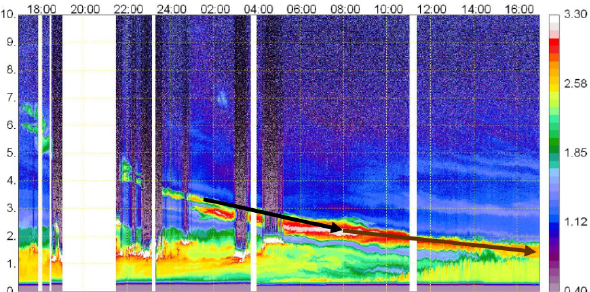
Figure 2. Logarithm of range-corrected signal of MULIS (multi- wavelength lidar system) at = 1064nm at Maisach from 16 April 2010, 17:00UTC to 17 April 2010, 17:00UTC and from 0 to 10km above ground; white areas denote periods without measurements (taken from Gasteiger et al., 2011). The two arrows indicate the descent of the plume during two time intervals.